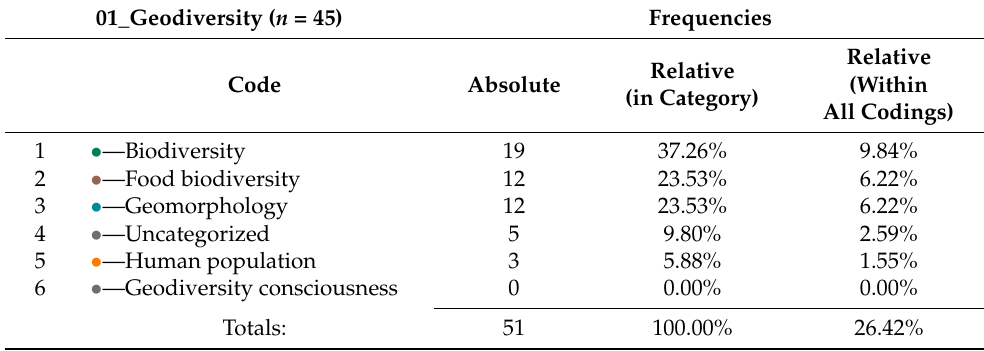
Table 2. Frequencies/distribution of codes (students’ perceptions) in the category geodiversity. 01_Geodiversity ( n = 45)